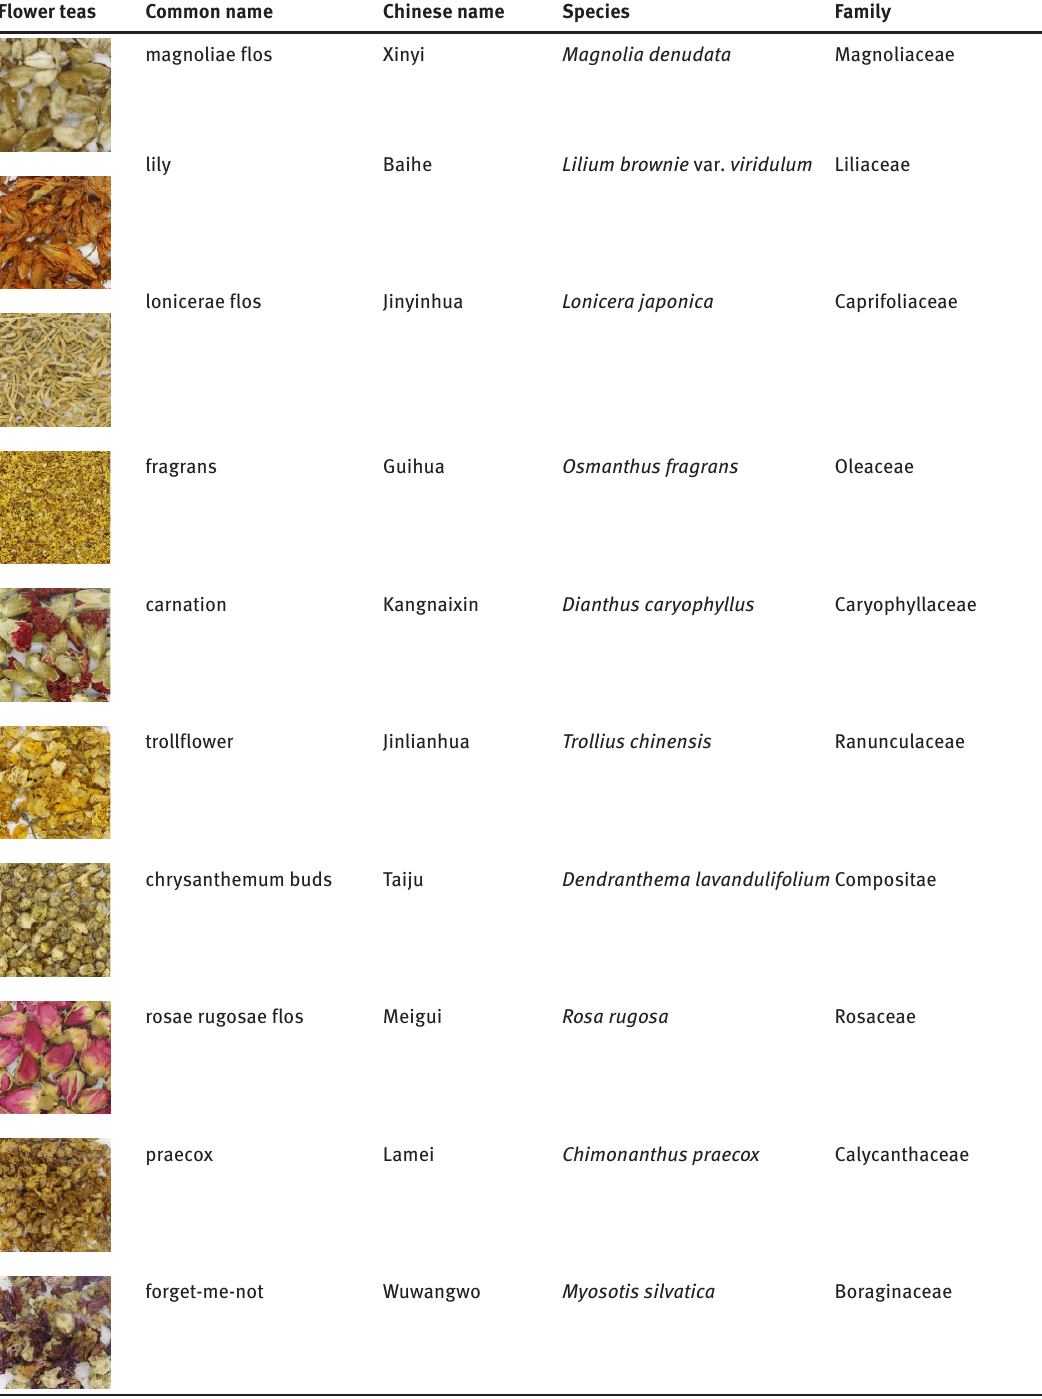
Table 1: Ten common flower teas in China collected from Kunming City. Flower